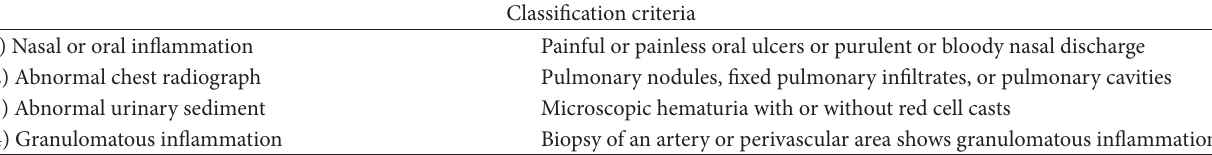
Table 2: ACR classification criteria for granulomatosis with polyangiitis (formerly, Wegener’s Granulomatosis). Classification criteria